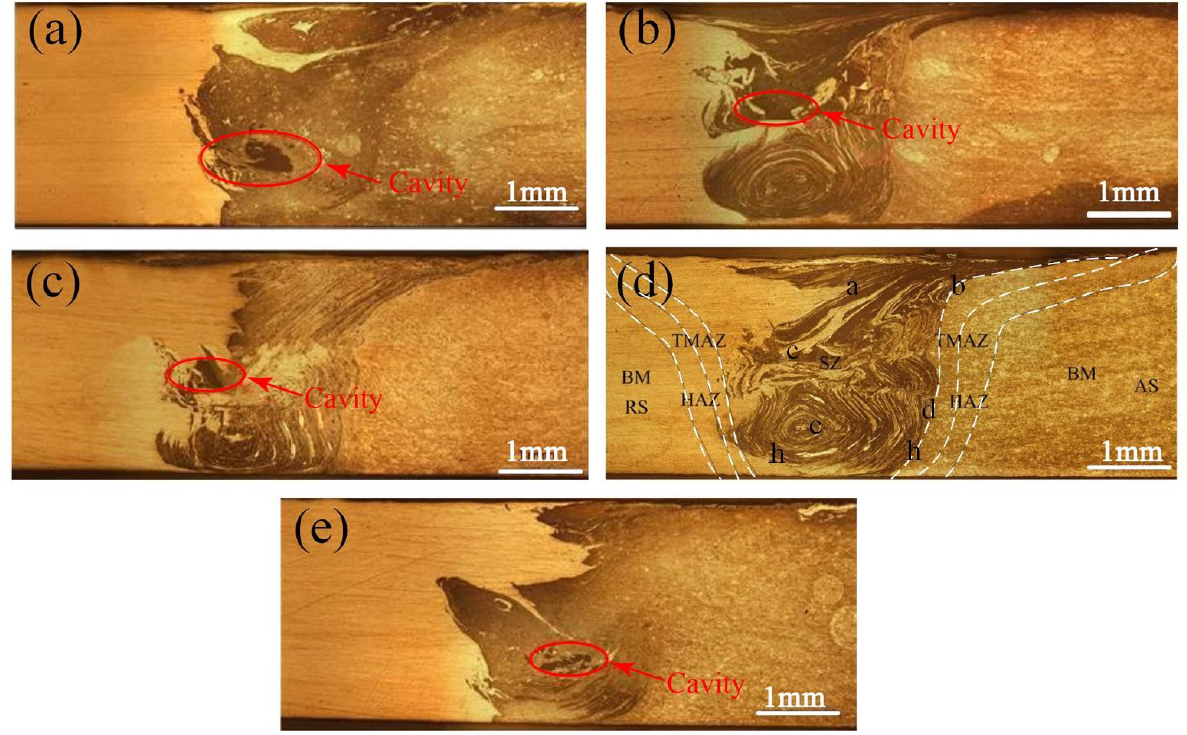
Figure 5: Macrostructures in cross-section of the Al/Mg joints at different welding speeds: (a) 30 mm/min, (b) 40 mm/min, (c) 50 mm/min, (d) 60 mm/min and (e) 70